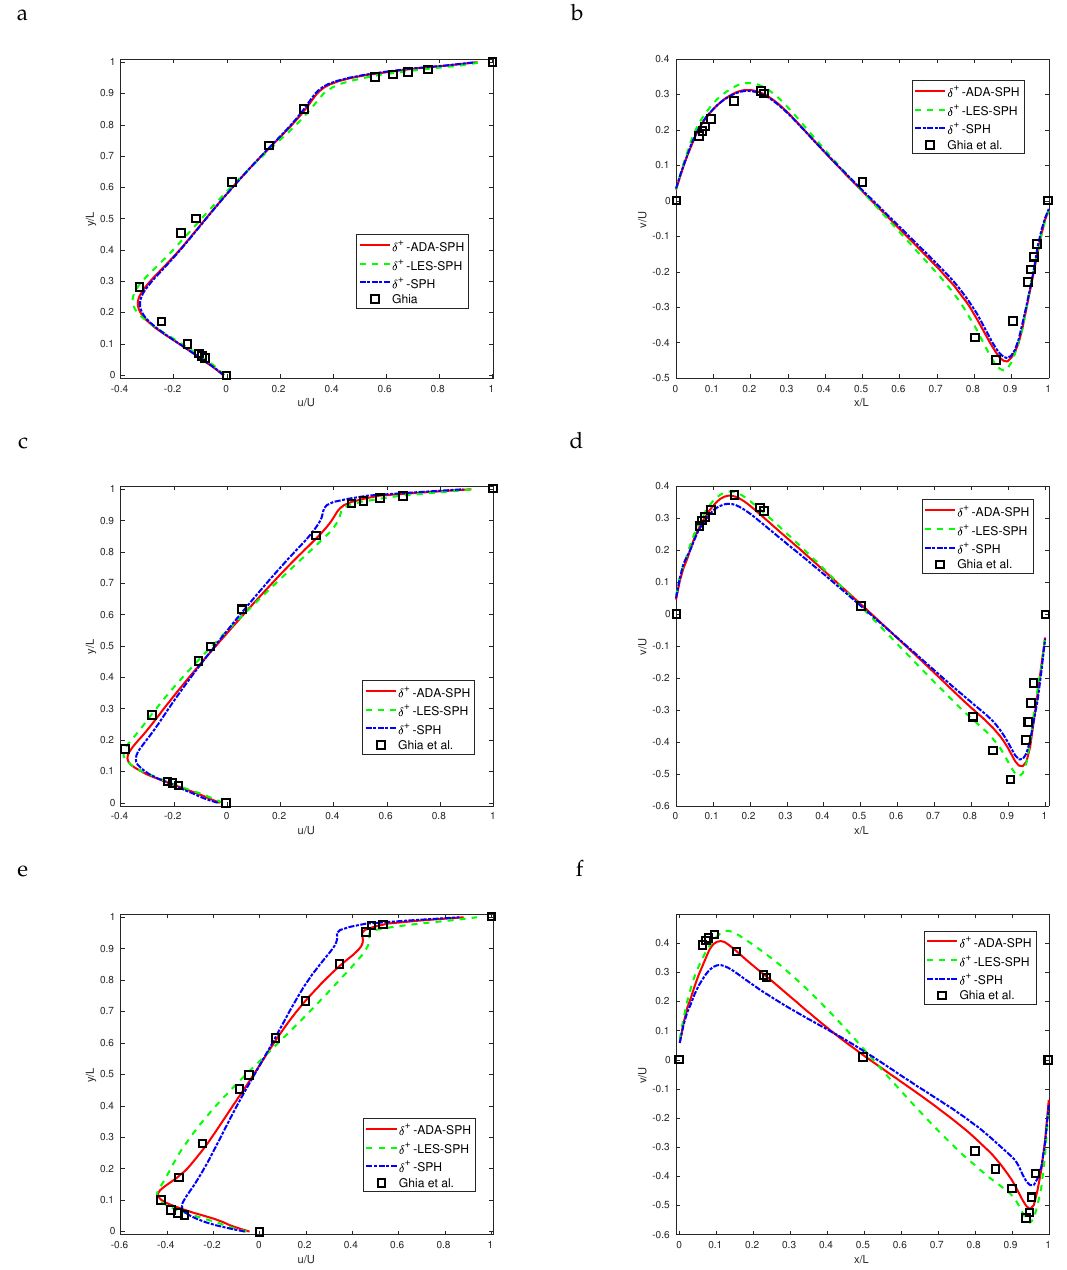
Figure 9. Lid-driven cavity flow: Velocity profiles along vertical ( left ) and horizontal ( right ) centerlines, computed for three different Reynolds numbers using 50 × 50 particles. The normalized u-velocity component is plotted on the left, whereas the normalized u-velocity component is plotted on the right. The solutions are compared with those of Ghia [42]. Figures ( a , b ) show the results for Re = 400, figures ( c , d ) plot the results for Re = 1000 and figures ( e , f ) show the results obtained for Re = 3200. In general, a good agreement is observed for the three schemes at low Reynolds number. However, as the Reynolds number is increased, the proposed method obtains more accurate results. We also